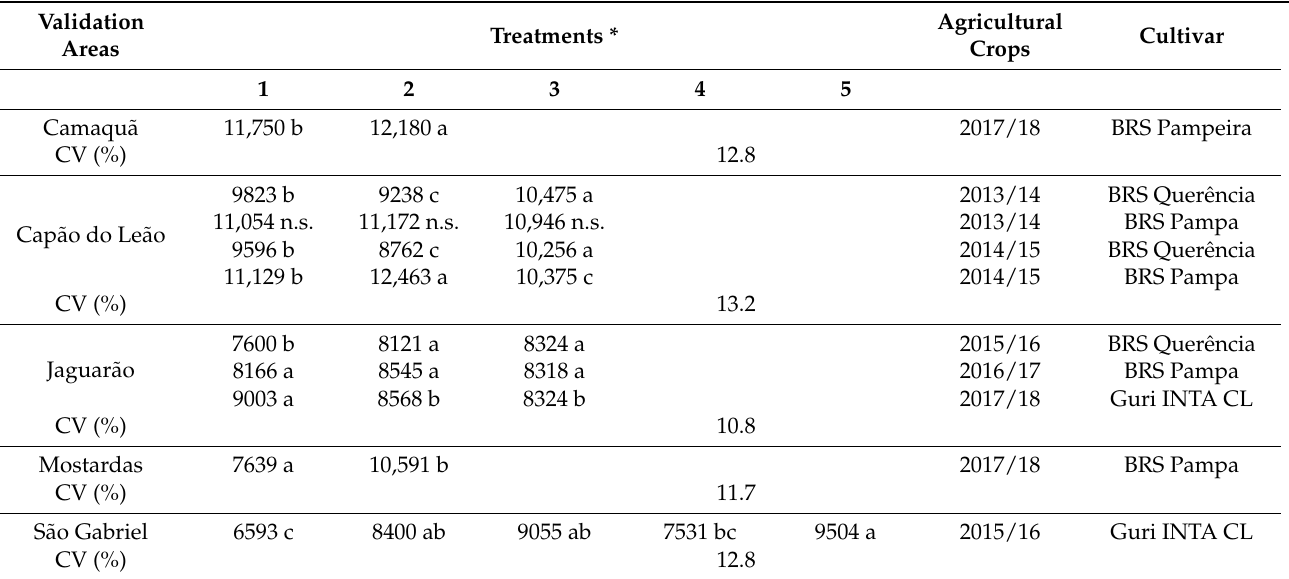
Table 9. Yield of rice grains (kg ha − 1 ) as a function of inoculation with Azospirillum brasilense (strains Ab-V5 and Ab-V6). Averages of the 2013/14, 2014/15, 2015/16, 2016/17 and 2017/18 harvests.